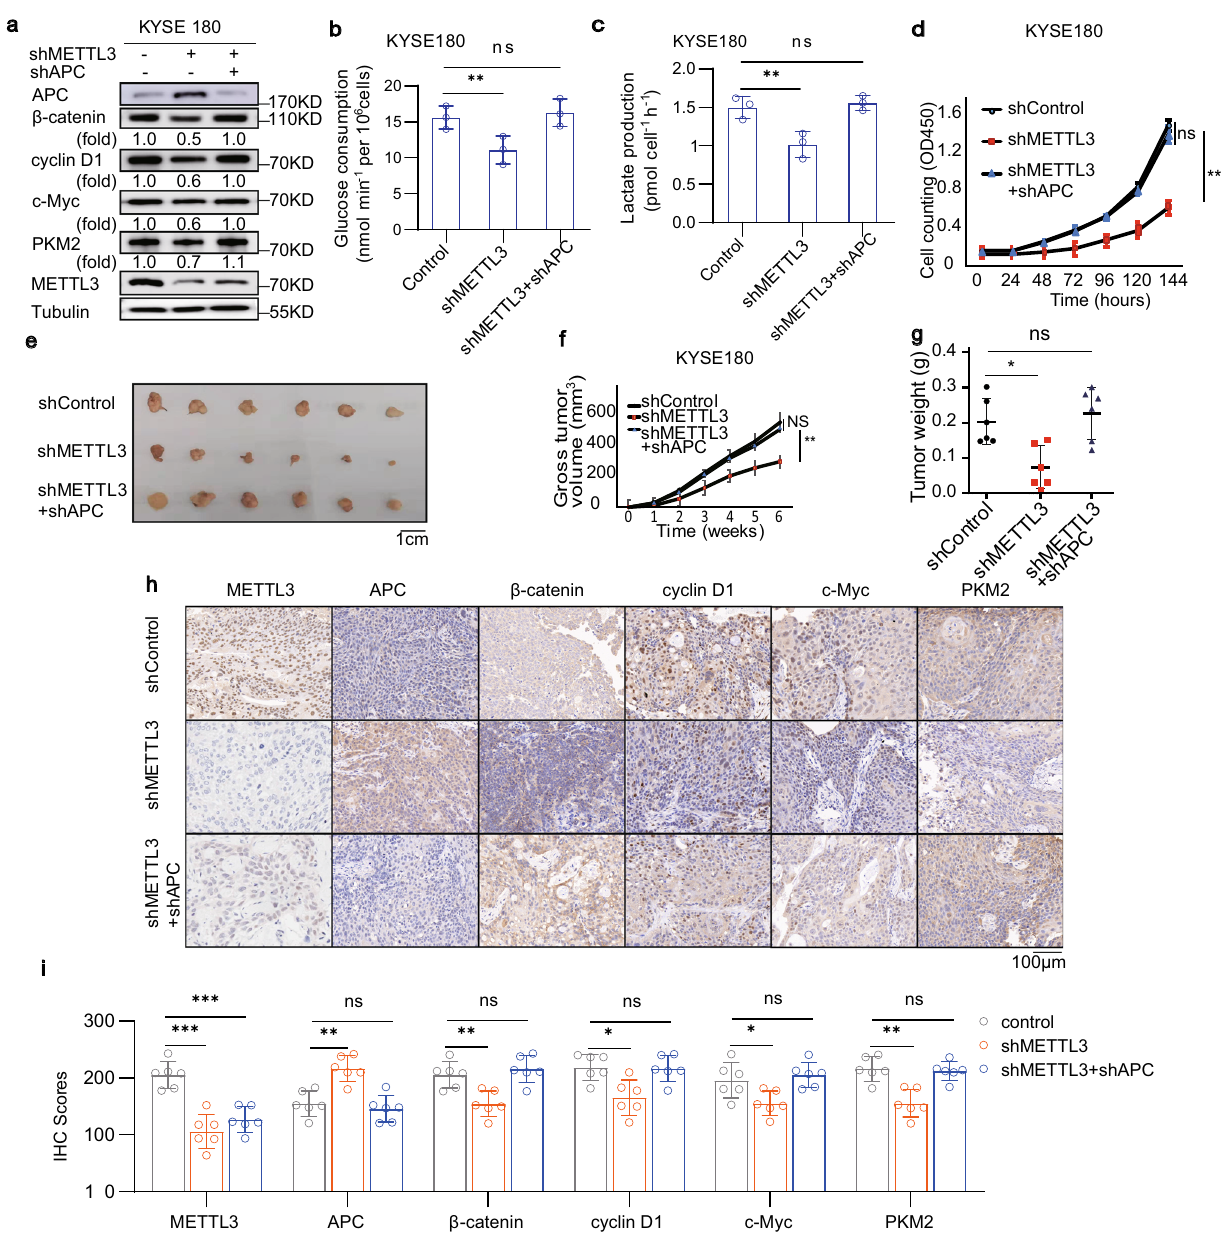
Fig. 6 METTL3 reduces APC expression and promotes β -catenin downstream gene expression, aerobic glycolysis, ESCC cell proliferation and tumour development. a Immunoblotting analyses of KYSE180 cells with or without METTL3 shRNA expression or combined METTL3 shRNA and APC shRNA expression were performed with the indicated antibodies for three times with similar results. b , c Glucose consumption ( b ) and lactate production ( c ) of KYSE180 cells with or without METTL3 shRNA expression, or combined METTL3 shRNA and APC shRNA expression were determined. Data represent the means ± SD of triplicate samples. ** p = 0.0093 ( b ) and p = 0.0062 ( c ) based on two-tailed Student ’ s t -test. ns, not signi fi cant. d KYSE180 cells with or without METTL3 shRNA expression or combined METTL3 shRNA and APC shRNA expression were cultured for the indicated periods of time and collected for cell counting. Data represent the means ± SD of triplicate samples. ** p = 0.0023 based on two-tailed Student ’ s t -test. ns, not signi fi cant. e – i KYSE180 cells with or without METTL3 shRNA expression or combined METTL3 shRNA and APC shRNA expression were subcutaneously injected into the fl ank regions of nude mice ( n = 6). Six weeks later, tumour sizes ( e ), volumes ( f ) and weight ( g ) were measured. Data represent the means ± SD of six mice in each group. ** p = 0.0025 ( f ), * p = 0.0135 ( g ) based on two-tailed Student ’ s t -test. h IHC staining of tumour tissues was performed with the indicated antibodies for three times with similar results. Representative images are shown. Scale bar, 100 μ m. i The protein expression levels of the indicated proteins were displayed. * p = 0.0269, ** p = 0.0033, 0.0069 and 0.0011 (left to right), *** p = 8.35E – 05, 0.0002 and 0.0008 (left to right) based on